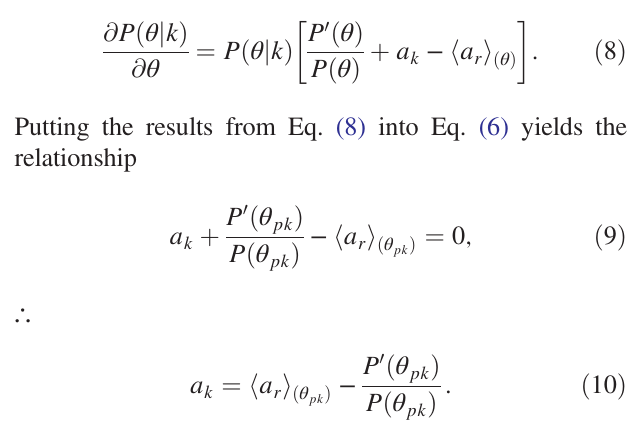
FIG. 2. Probability distributions for a student having a par- ticular value of θ , given that they chose one of the response options to item 14 on the FMCE. Curves were generated from Eq. (5) using the parameters from Table I, and assuming a standard normal distribution for P ð θ Þ and values of P 14 ð k Þ that normalize the probability